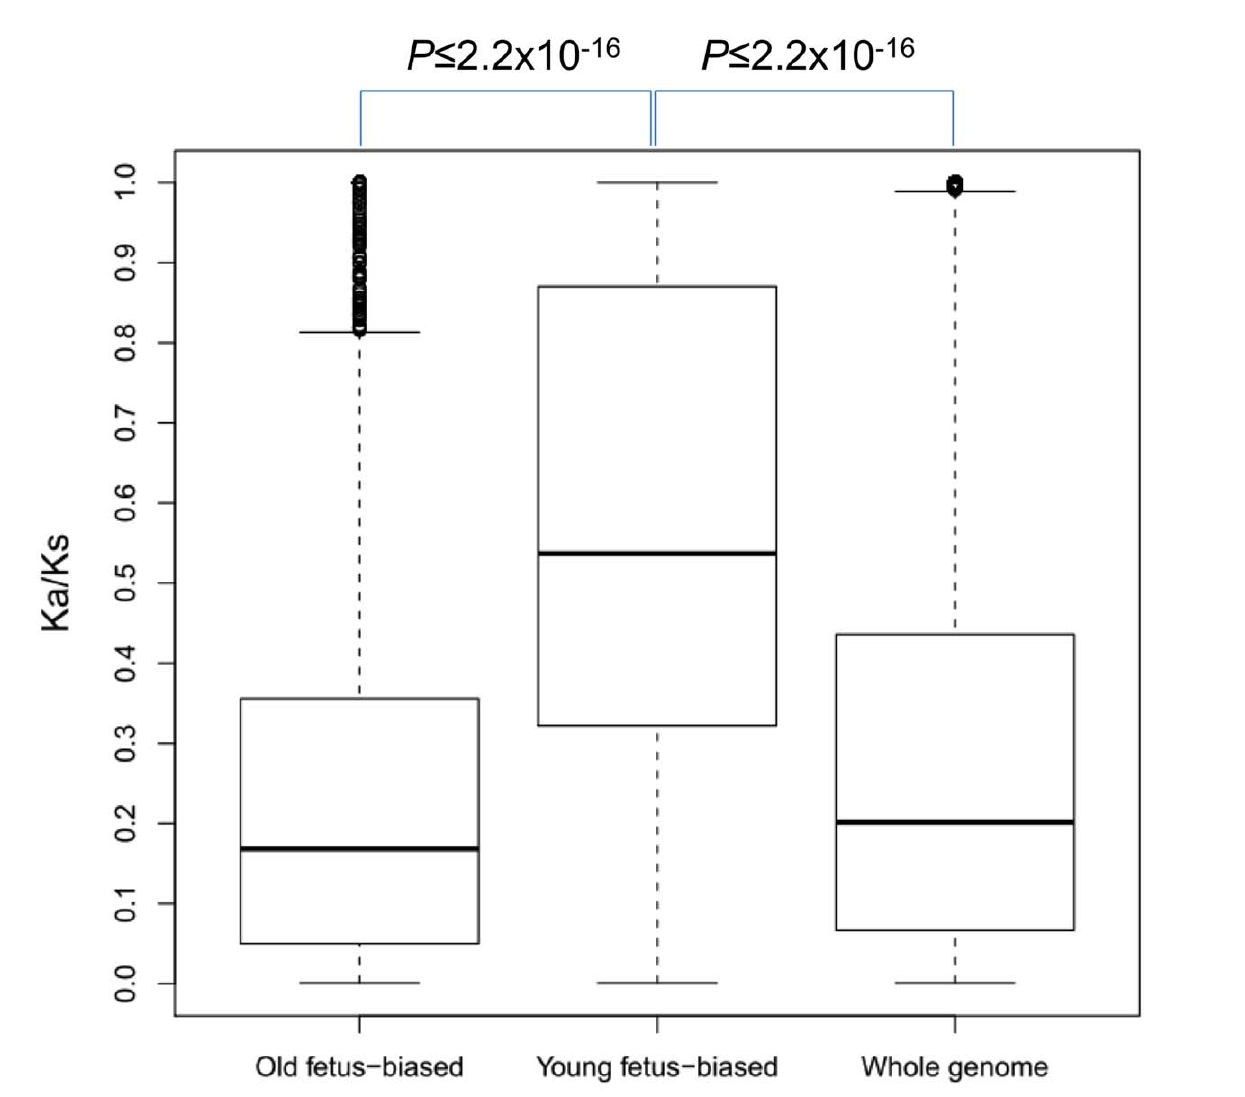
Figure 4. Ka/Ks distribution across different group of genes. All Ka/Ks values greater than 1 were trimmed to 1.